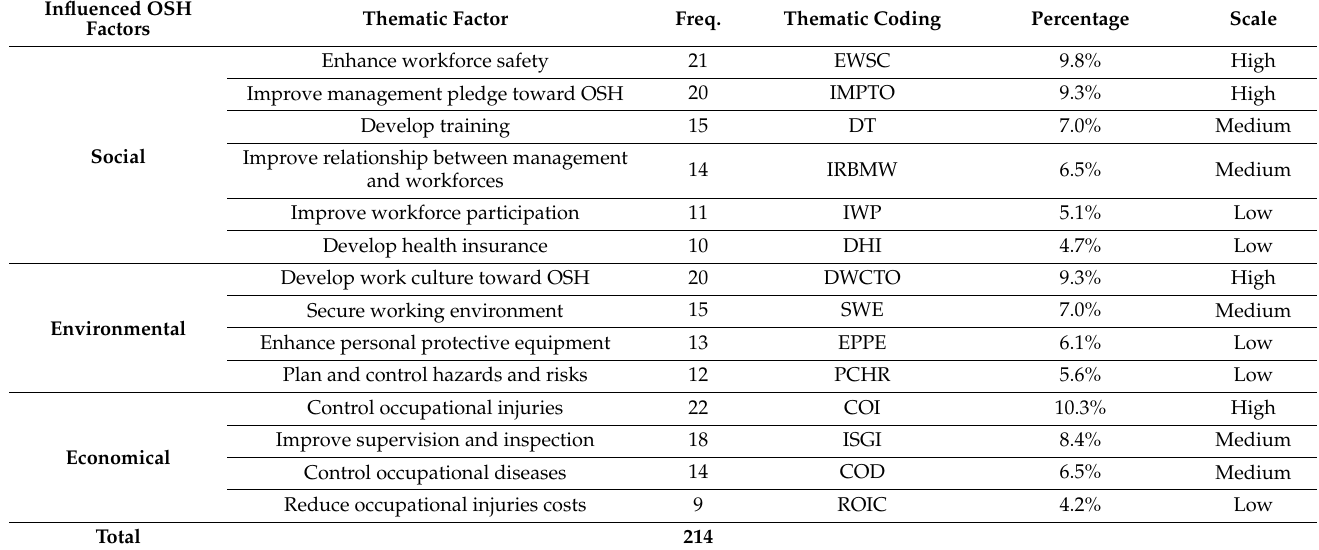
Table 7. Research findings (source: own